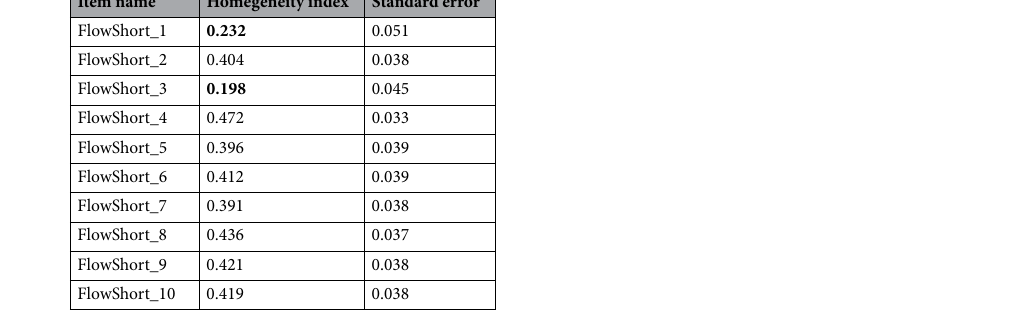
Table 2. Item-level homogeneity analysis for Flow Short Scale. Items with homogeneity index value < 0.30 are in